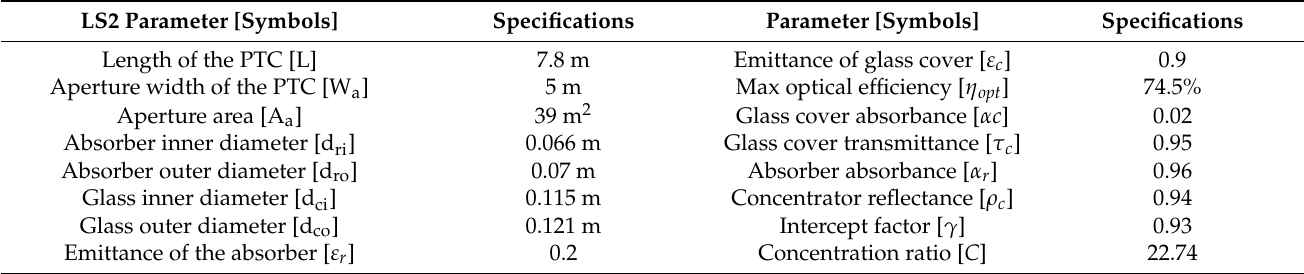
Figure 1. A detailed cross-section schematic of LS2 PTC. Table 2. LS2 parabolic trough dimensions.